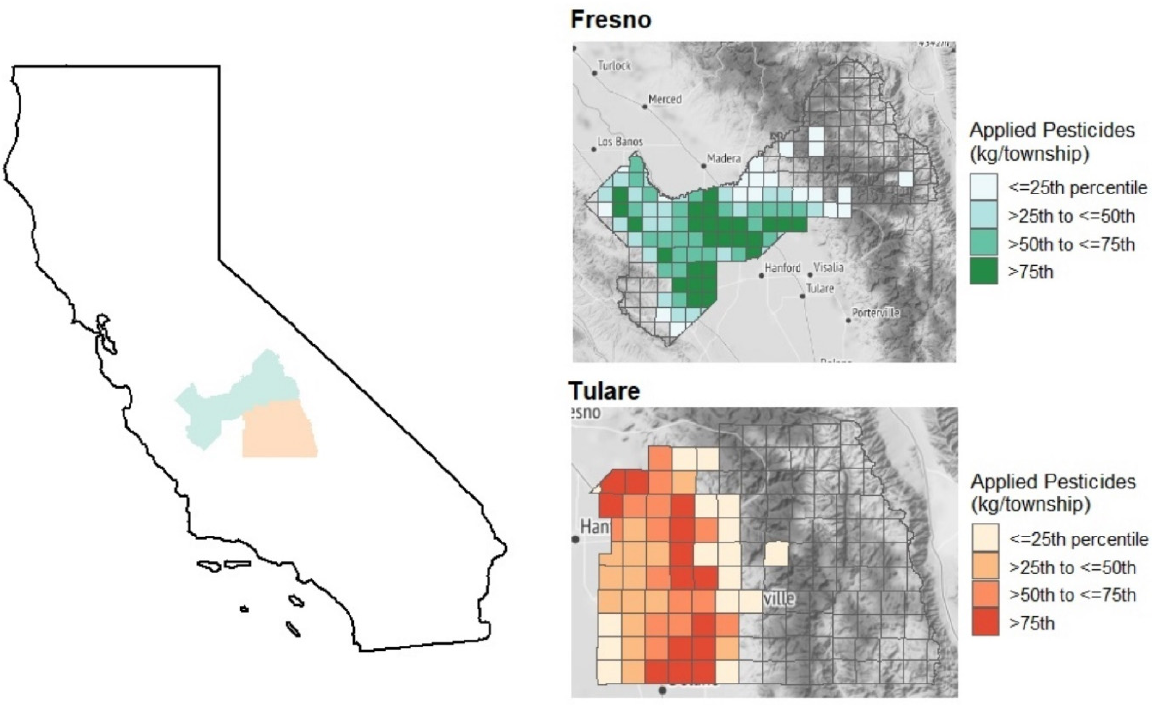
Figure 1. Map of study areas: Fresno (green) and Tulare (red) counties, CA. Identification of high pesticide exposure by county California Pesticide Use Report data, 2018.